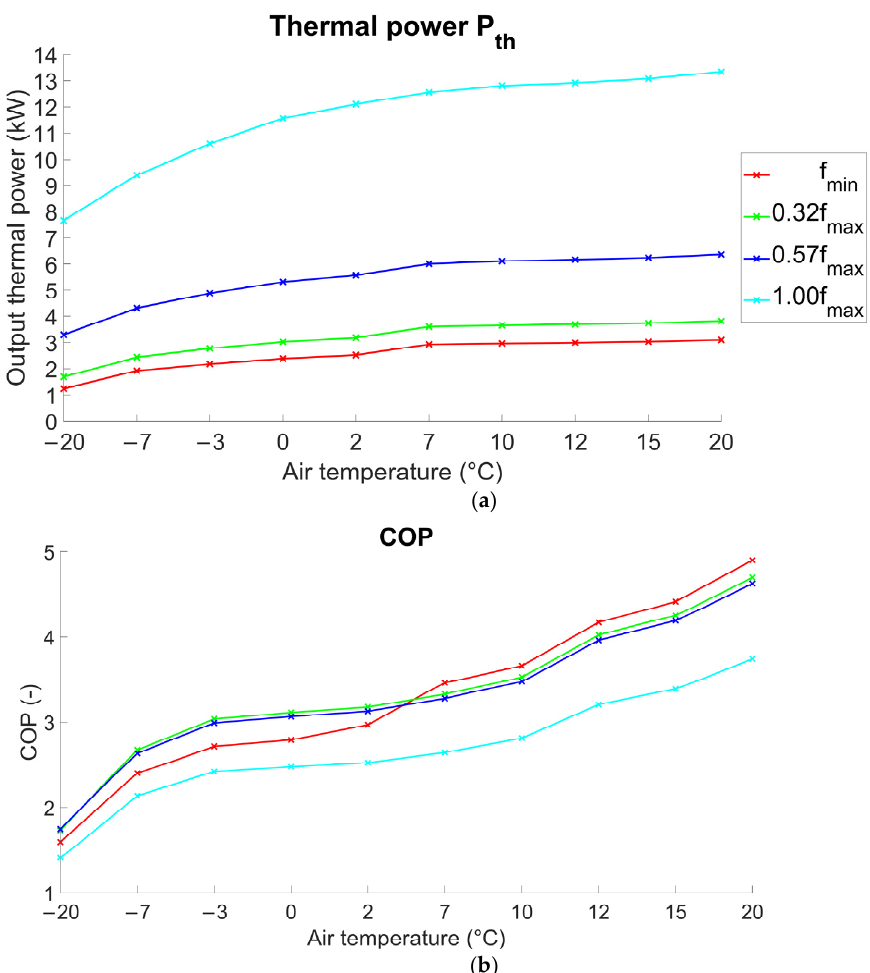
Figure 4. Thermal power output ( a ) and COP ( b ) characteristics of the heat pump installed as a generation system in building B1 located in Milan.